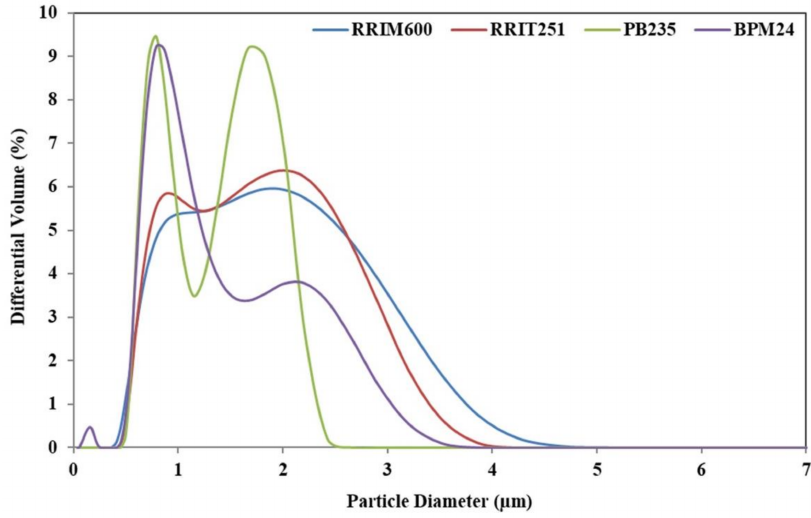
Figure 2. Particle size distribution of the fresh natural latex from four different Hevea brasiliensis clones.